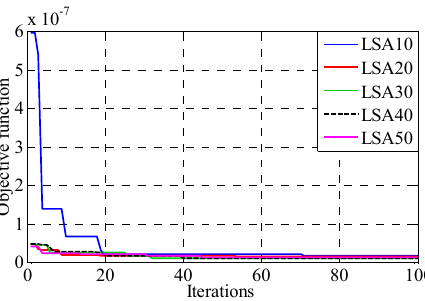
Figure 22. Objective function with iteration of the hybrid LSA ‐ ANN for different population sizes.